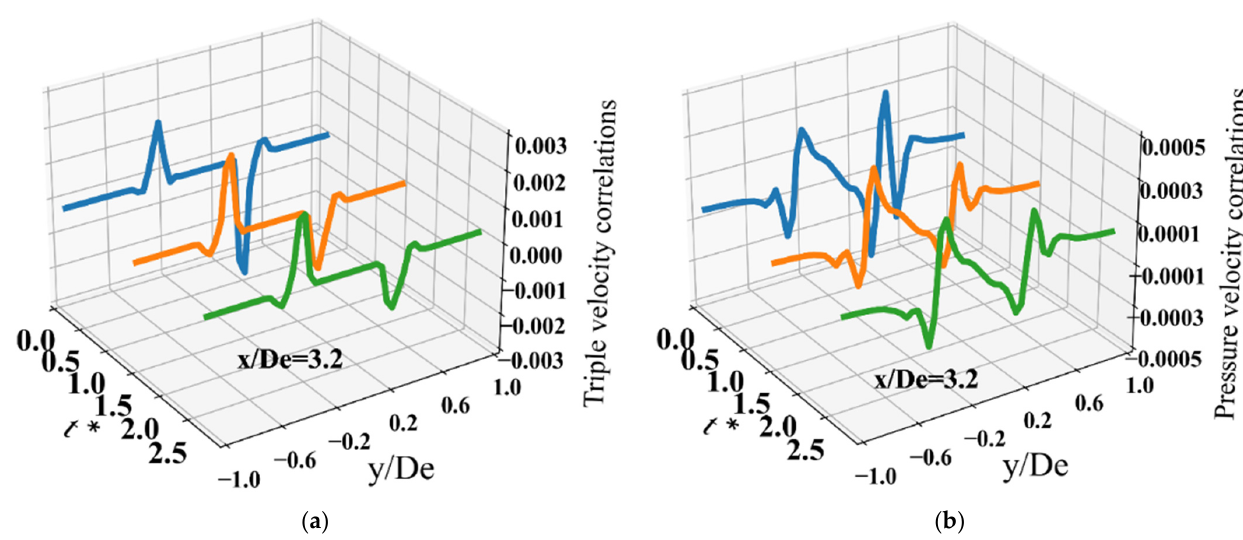
) for LEShot on minor j